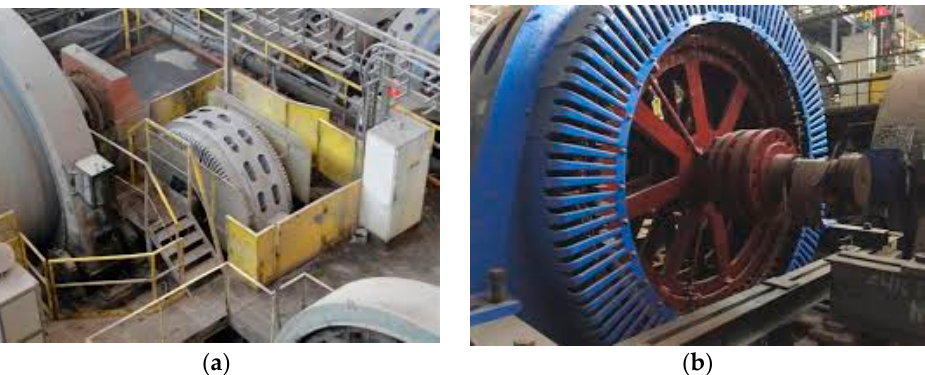
Figure 2. Ball mill drive system with low-speed SAS motor without intermediate gearbox: ( a ) prior to modernization, ( b ) after modernization on the right [34].